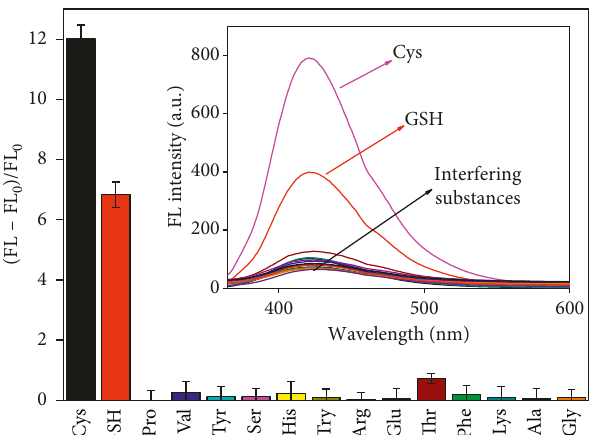
Figure 7: Selectivity of the fluorescent assay for biothiols over other biomolecules. The concentration of Cys or GSH was 100 μ M, and the other interference non-thiol analytes were 1 mM. The excitation wavelength was 355nm, and the emission at 420nm was monitored. Inset shows the corresponding fluorescence spectra of NRPCNSs in the presence of Cys, GSH. and the potential